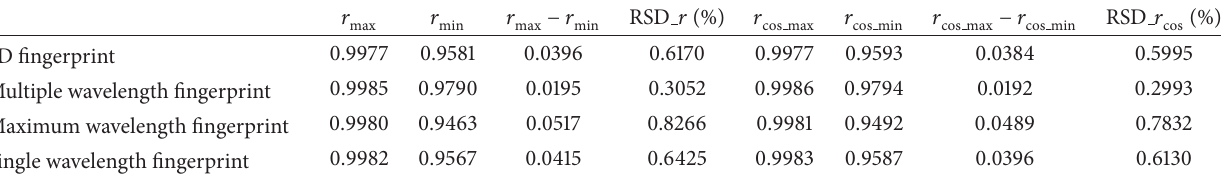
Table 1: Range and dispersion degree of similarities based on four types of fingerprints.